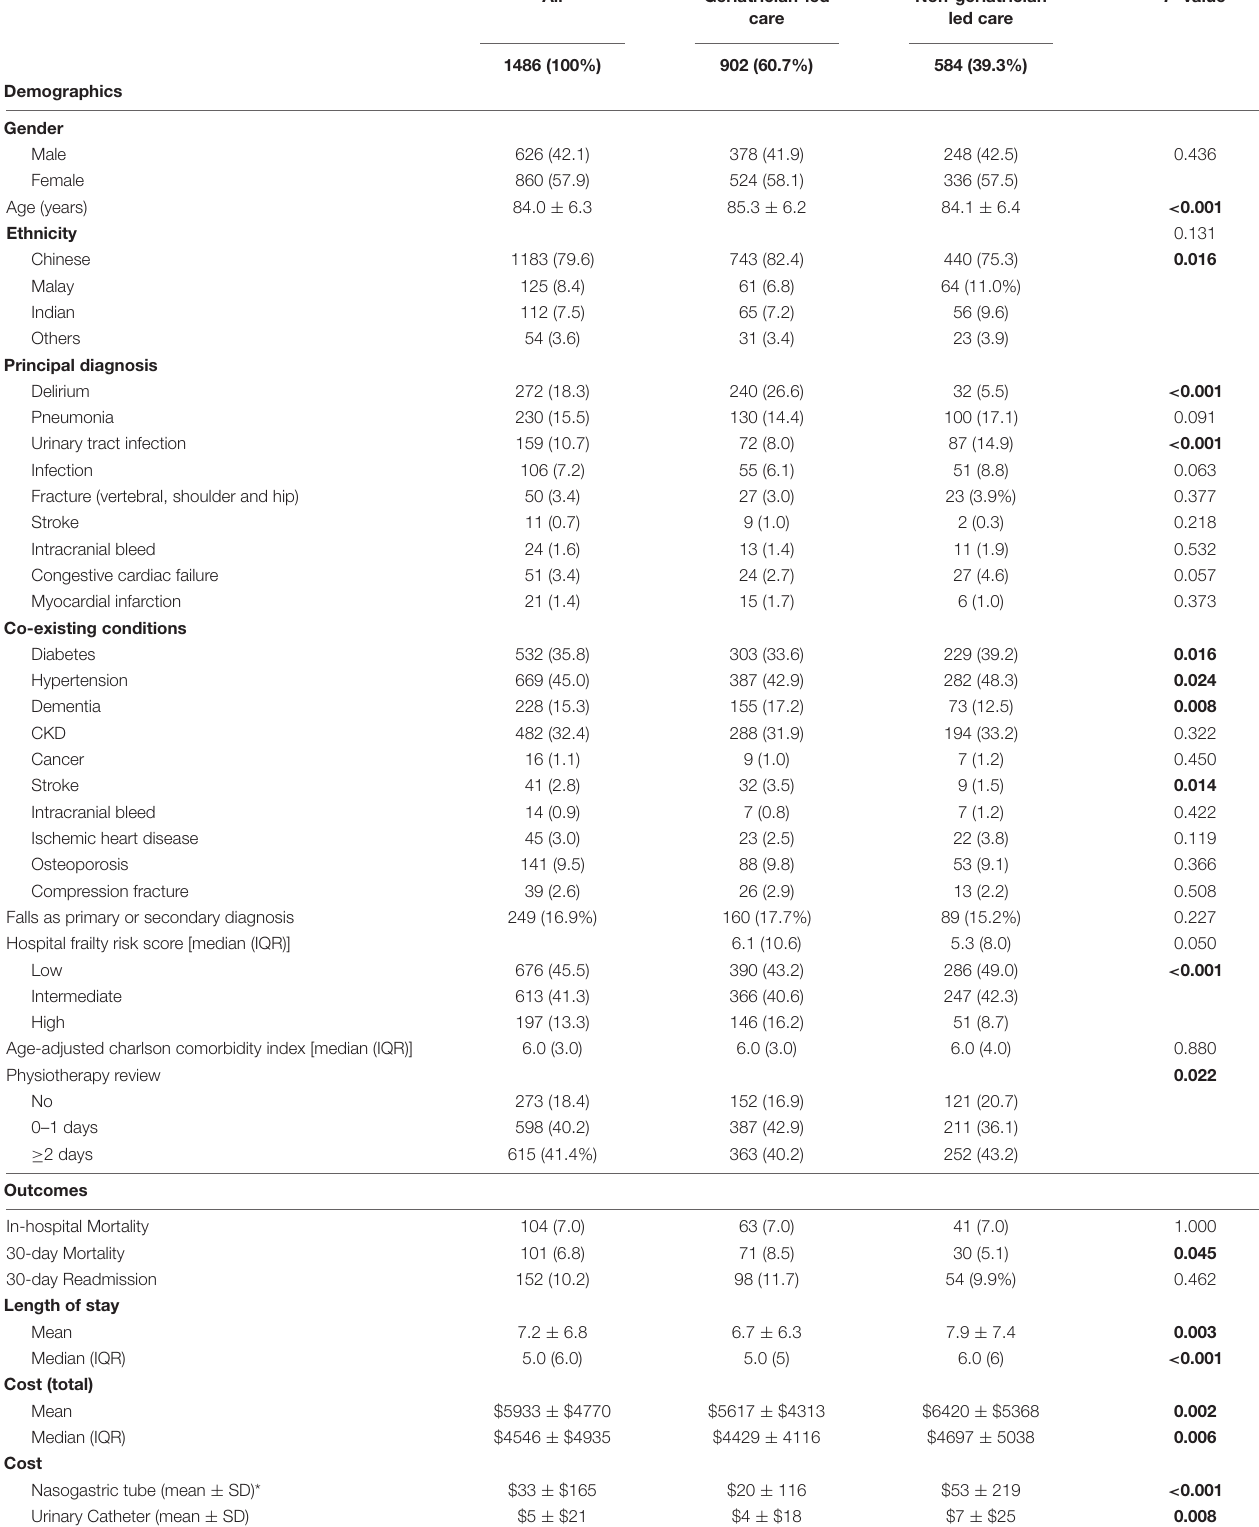
TABLE 1 | Demographics and